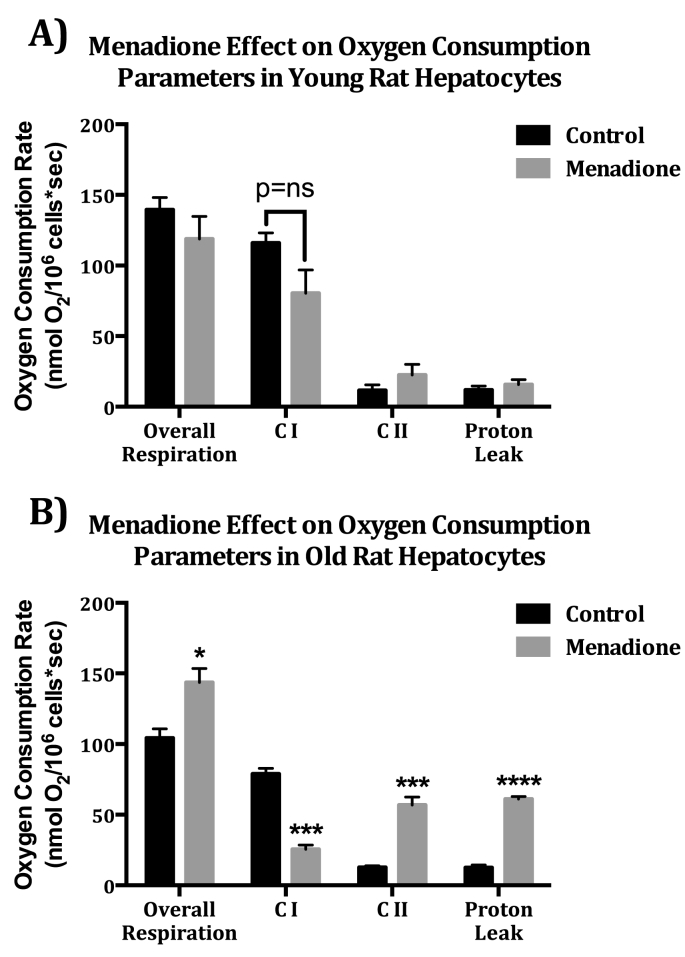
Menadione treatment (300 μM) causes marked age-related differences in O2consumption parameters A. In young rat hepatocytes, menadione exposure did not have a significant effect on overall O2 consumption, or O2 consumption linked to Proton Leak, CI, or CII (Student's t-test, N = 4) B. In hepatocytes from old rats, overall O2 consumption as well as O2 consumption linked to Proton Leak, CI, and CII were significantly different. (*p = 0.03105, ***p < 0.001, ****p < 0.0001, N = 4, Student's t-test).